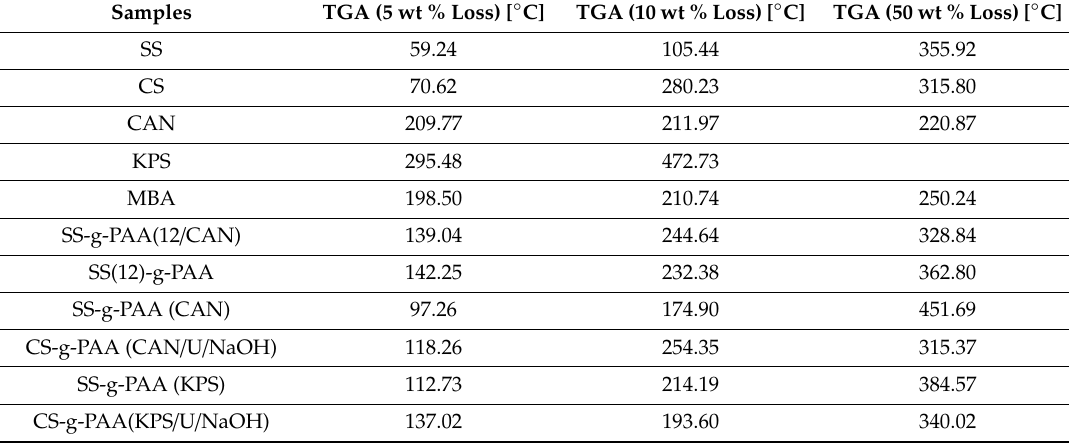
Table 2. The mass loss results derived from thermogravimetric analysis